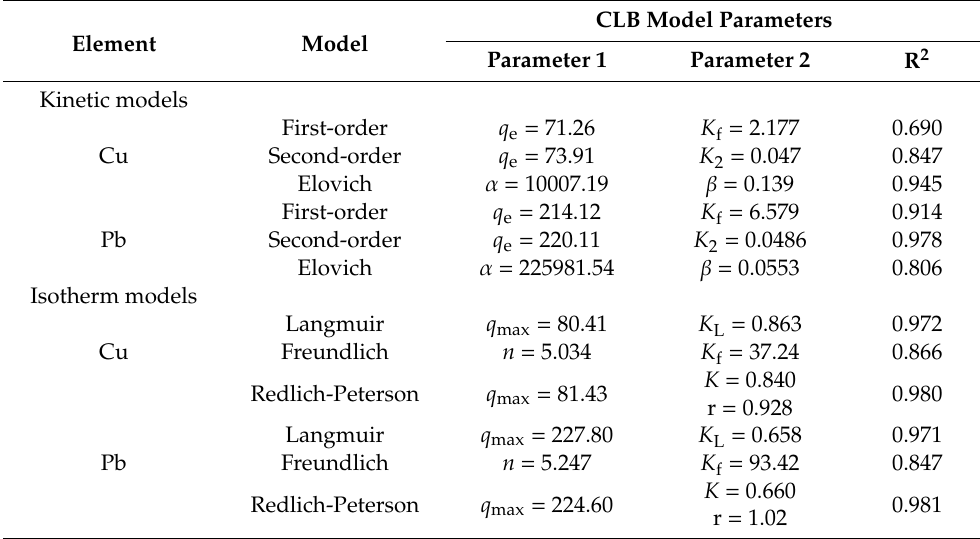
Table 2. Fitting parameters of kinetic models and isotherm models for Cu(II) and Pb(II) sorption onto CLB.